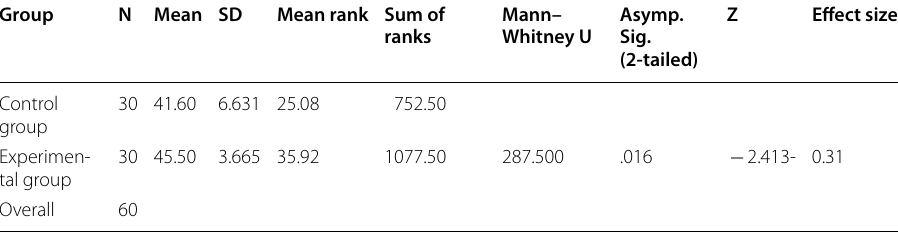
Table 6 Mann–Whitney U test for the experimental and control groups’ scores in the achievement